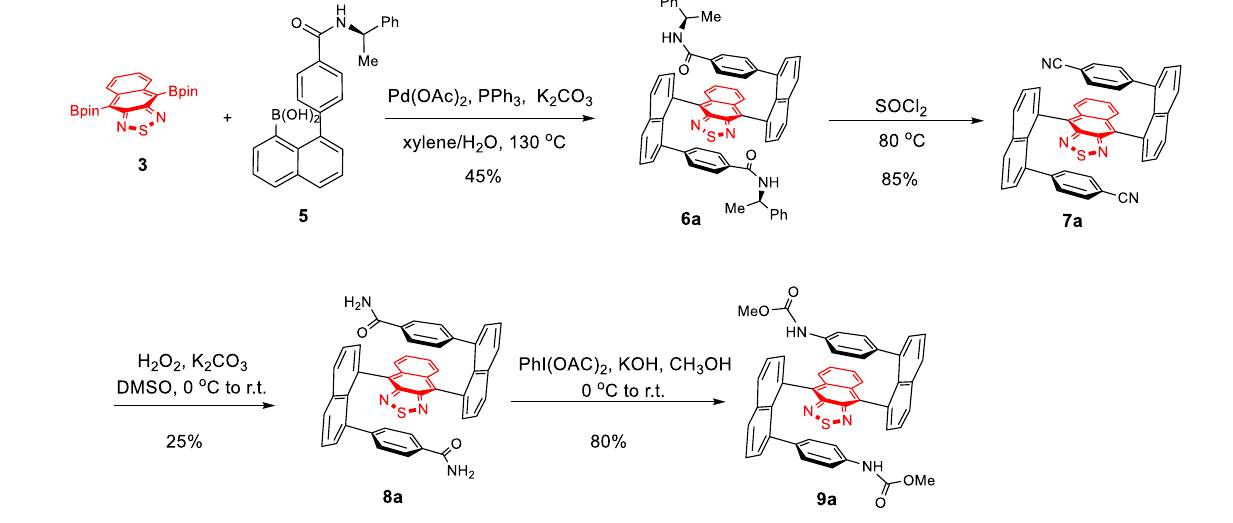
SCHEME 3 | Asymmetric synthesis of multilayer 3D target 9a .